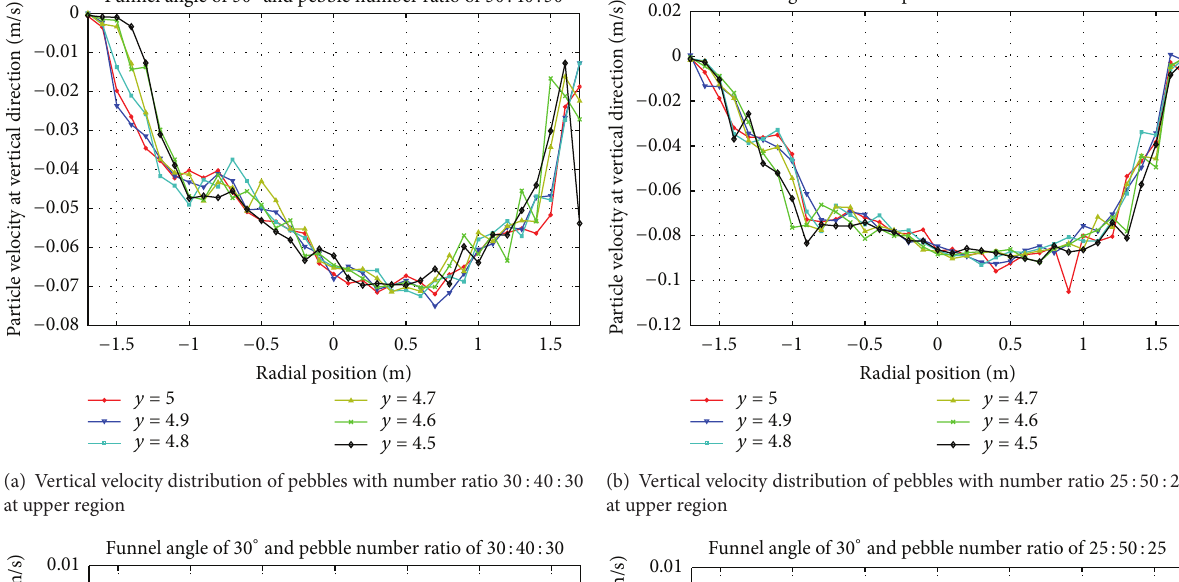
Funnel angle of 30 ∘ and pebble number ratio of 25 : 50 : 25